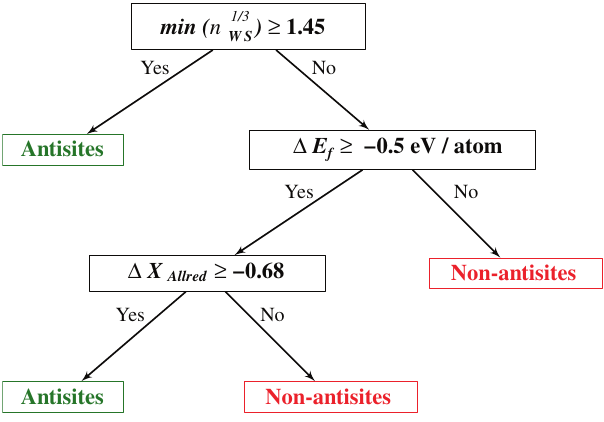
Fig. 4 DT- based classi fi cation scheme to predict the dominant defect types in B2